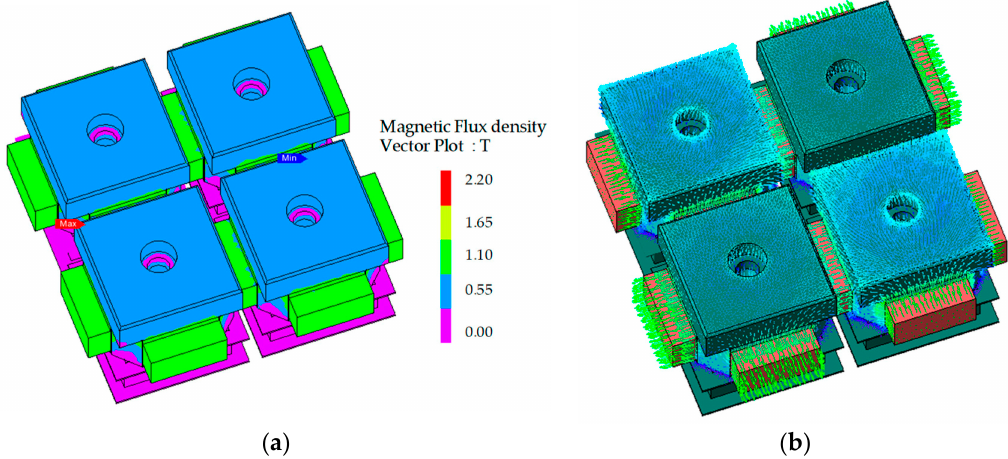
model. model. 257